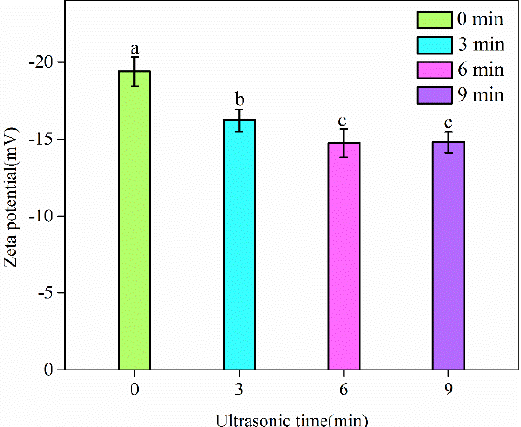
Figure 5. The zeta potential of oil droplets in SC stabilized emulsions. Different letters above standard deviation bars are significantly different ( p < 0.05).